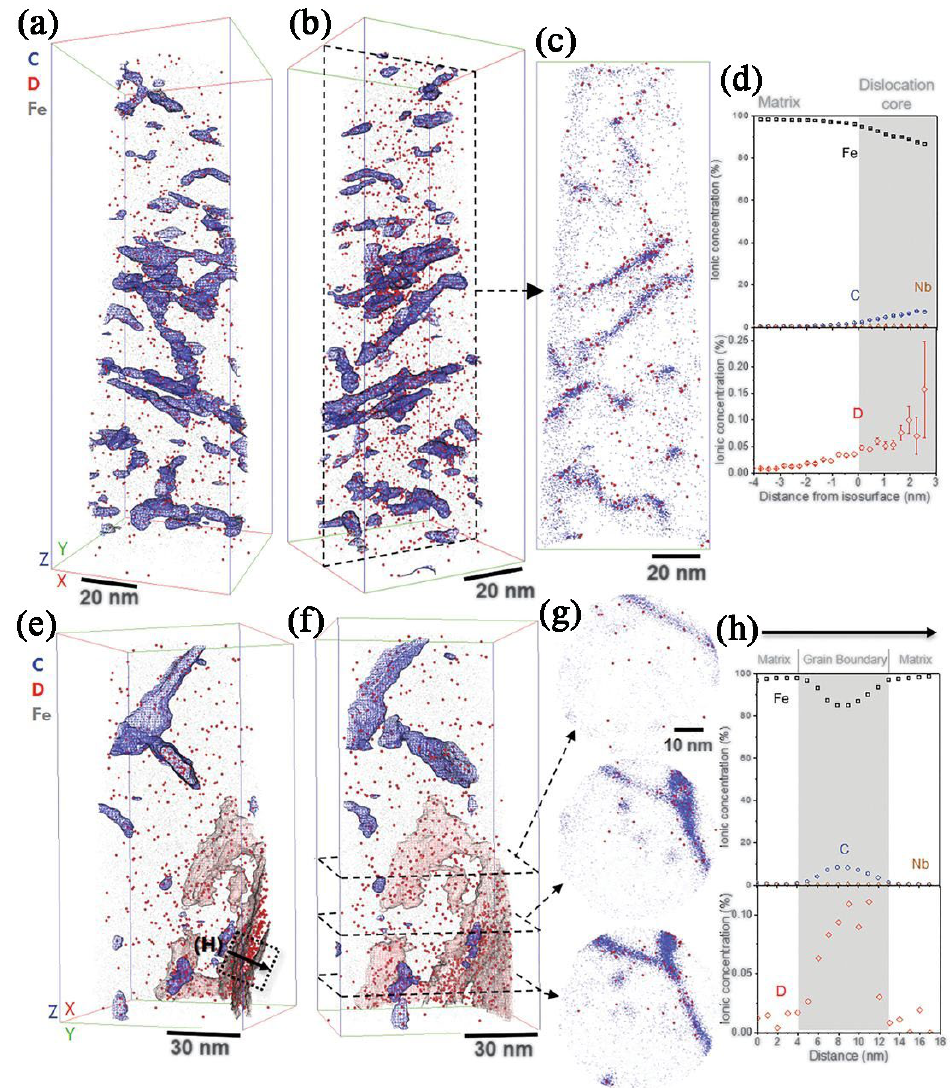
Figure 11. APT analyses of D-charged martensitic steel samples containing ( a – d ) dislocations and deuterium (D, large red spheres), carbon (C, small blue spheres) and iron (Fe, small gray sphere), and ( e – h ) GBs and Fe, C, D elements [95]. Reprinted with permission from [95]. Copyright 2022 AAAS.